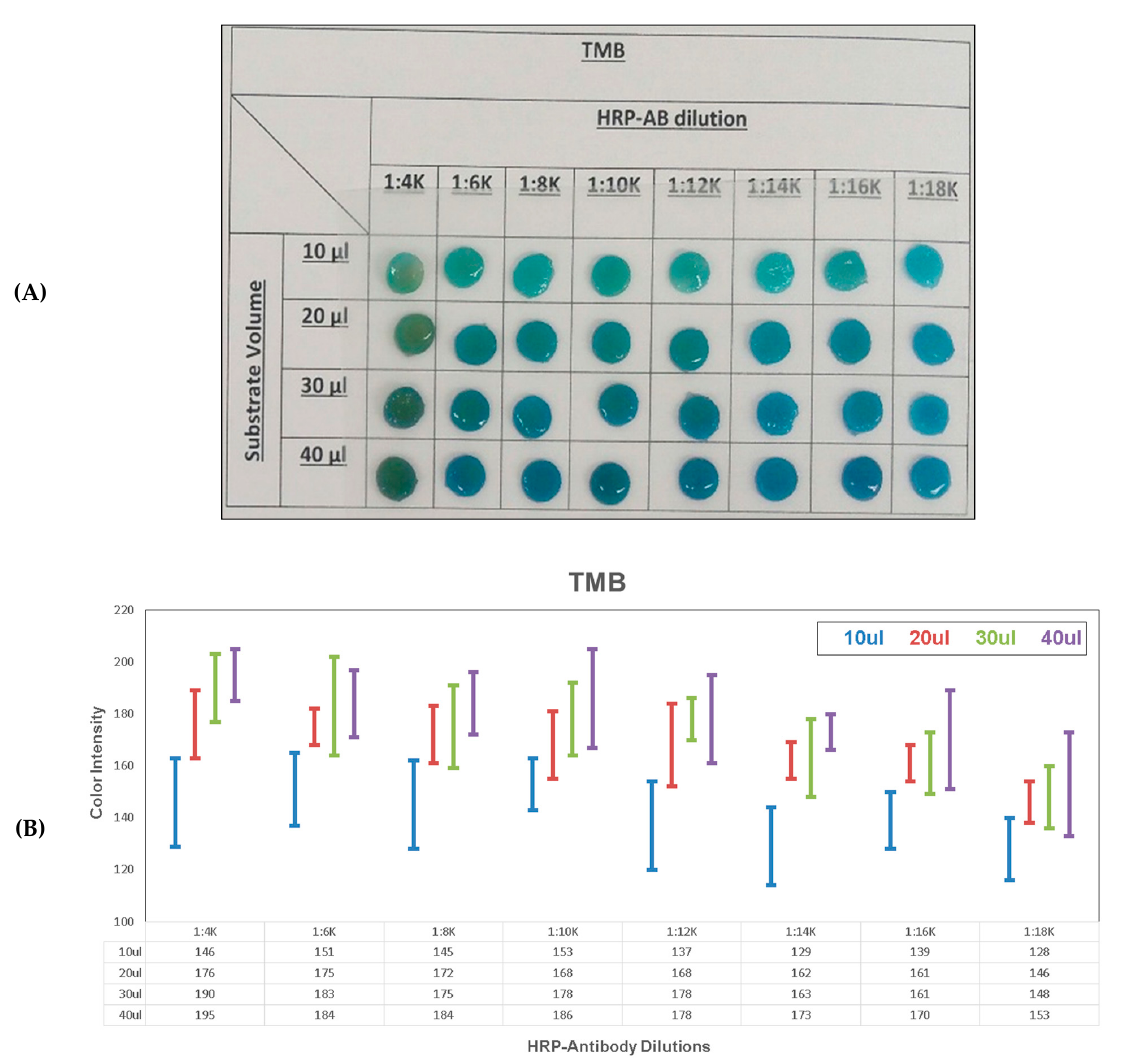
Figure 4. TMB unstopped colorimetric signal on membrane. Colorimetric signal on membrane with a range of HRP-antibody concentrations and a range of TMB substrate volumes: ( A ) picture and ( B ) color intensity analysis.